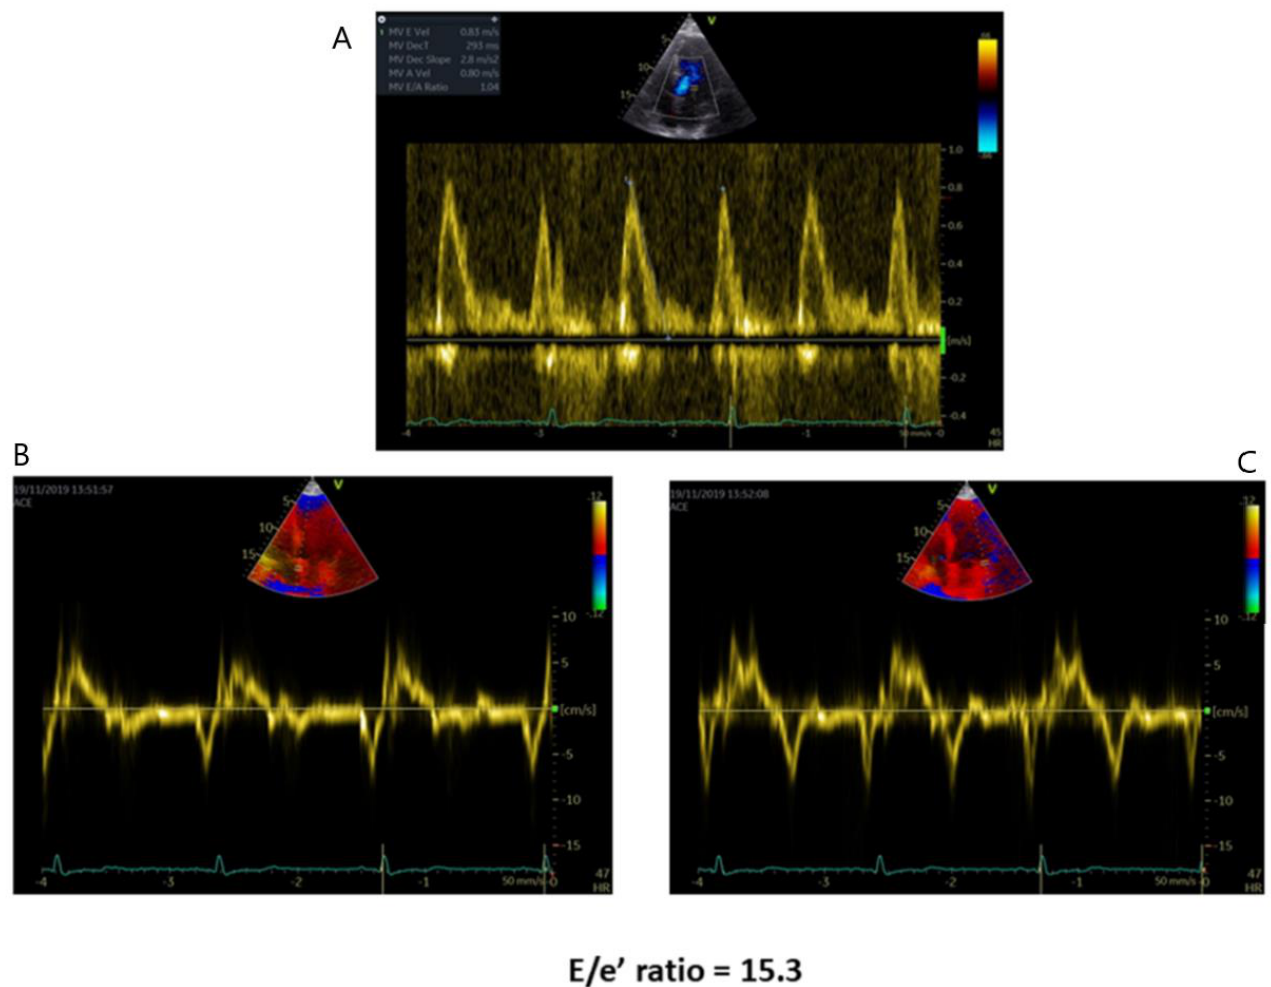
Figure 2. Diastolic dysfunction in AFD patients with preserved LVEF. ( A ) E/A ratio tissue. ( B ) Doppler recordings of septal mitral annular velocities. ( C ) Tissue Doppler recordings of lateral mitral annular velocities.